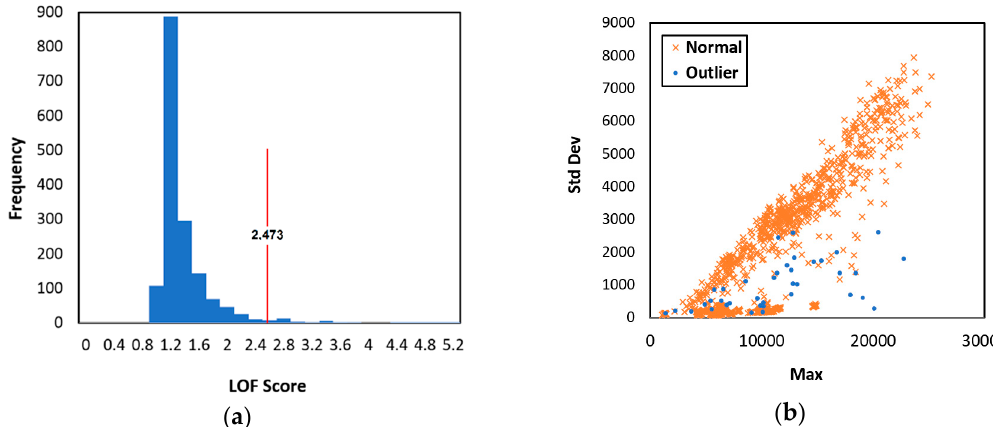
Table 5. Optimal local outlier factor (LOF) outlier detection.